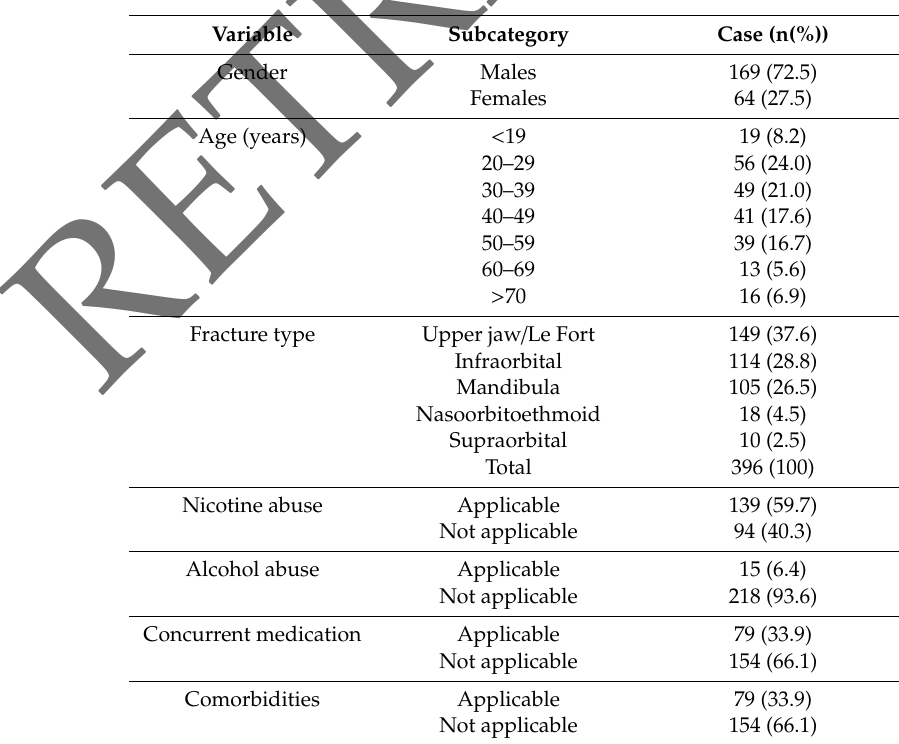
Table 1. Descriptive statistics within the study population: age, gender, fracture type, and health status. Totals of the percentages may not be exactly 100% because of